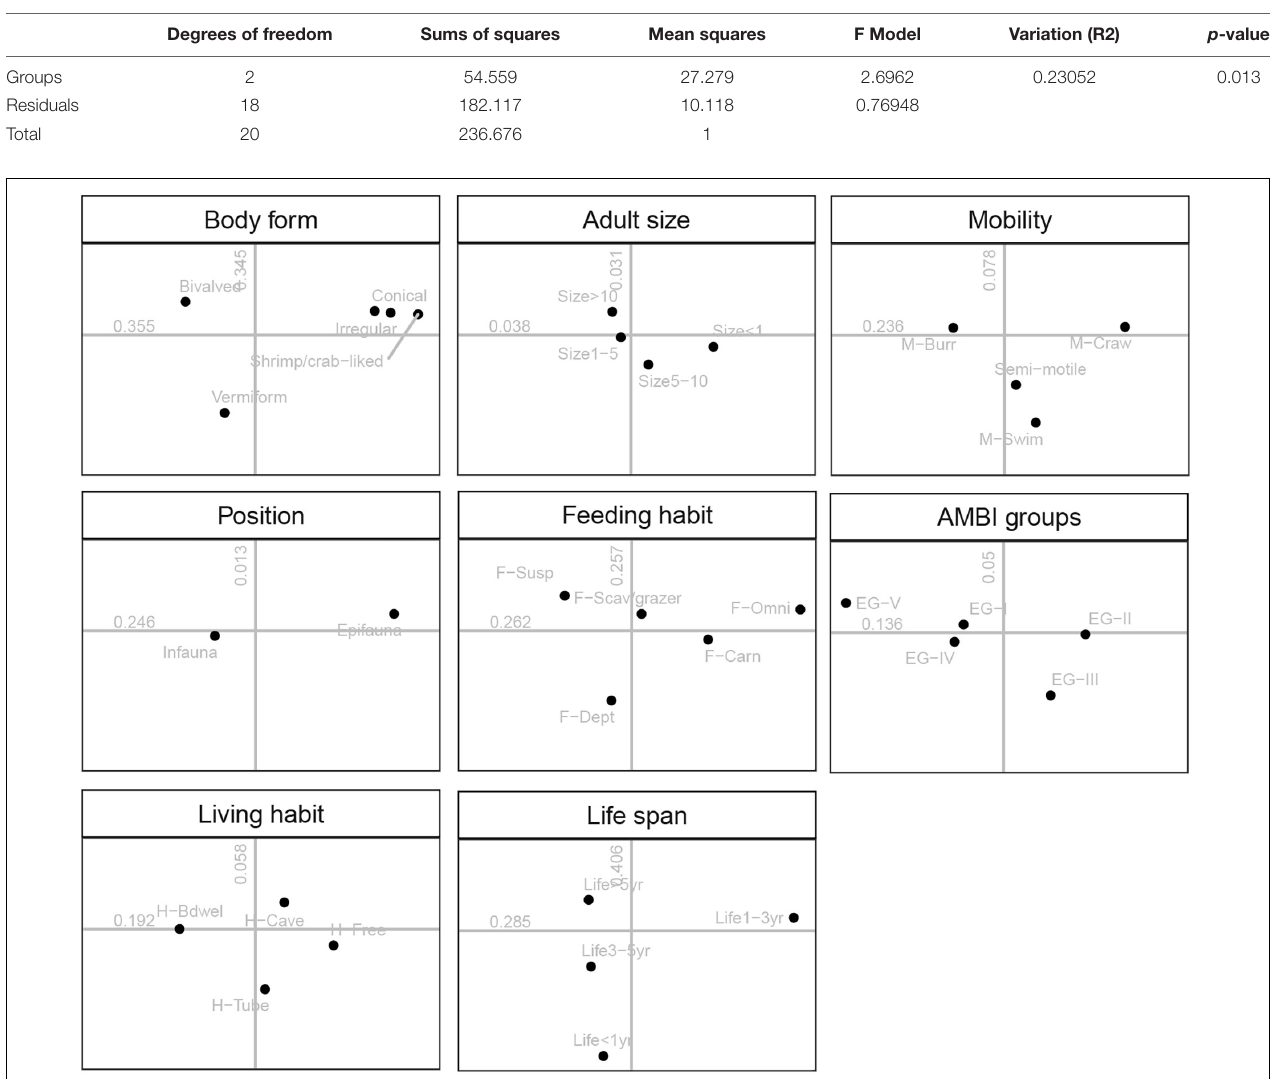
TABLE 4 | PERMANOVA test for trait composition of macrobenthic communities in three intertidal zones.